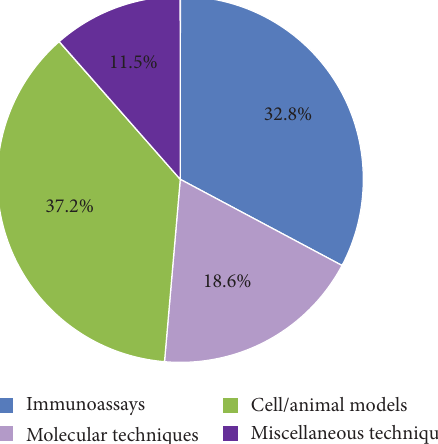
Figure 3: Categories represented by the top 15 regenerative medicine techniques. Immunoassays and cell/animal models were each used in 217 and 246 studies, respectively, compared to molec- ular and miscellaneous techniques which were used in 123 and 76 studies, respectively. The percentages of studies these categories represent are provided in the